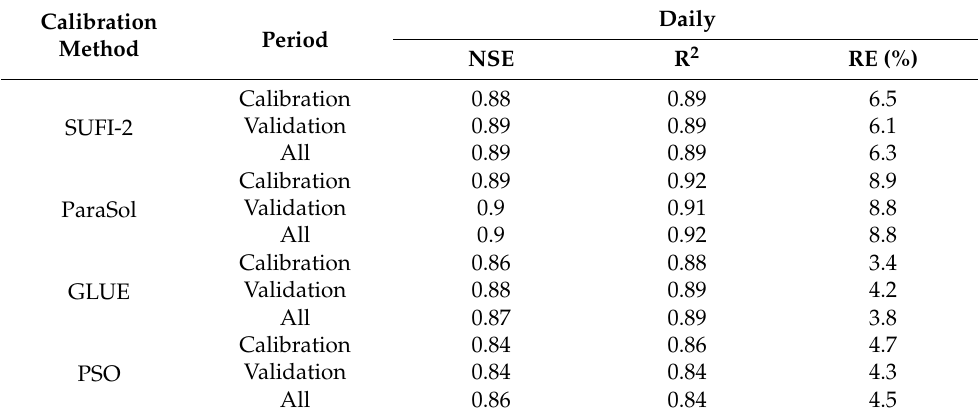
Figure 2. Rankings of the parameter sensitivities and the values of the absolute value of t-Stat and p -value yielded by Sequential Uncertainty Fitting procedure version 2 (SUFI-2) ( a ), Parameter Solu- tion (ParaSol) ( b ), Generalized Likelihood Uncertainty Estimation (GLUE) ( c ) and Particle Swarm Optimization (PSO) ( d ) (Notation: ‘V_’ and ‘R_’ represent a replacement and a relative change to the initial parameter values, respectively). Table 3. Model evaluation metrics in the streamflow simulation during the calibration (1975 to 1989), validation (1990 to 2004), and the whole periods (1975 to 2004) at daily